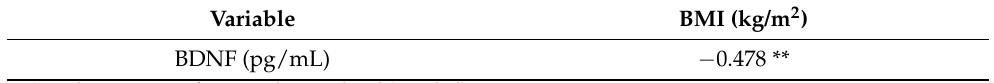
Table 4. The correlation between the BDNF concentrations and BMI (Spearman’s rho test). Variable BMI (kg/m 2 ) BDNF (pg/mL) − 0.478